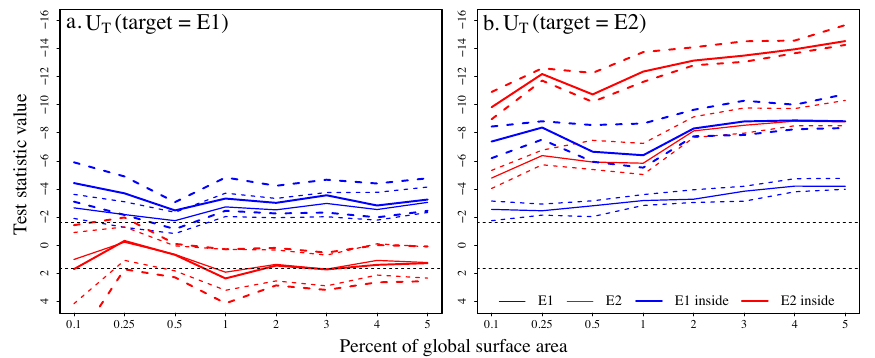
Fig. A1. As Fig. 7, with E1 (blue) and E2 (red) ensemble averages. The thick lines denote the use of inside averaging, whilst the thin lines denote outside averaging (as presented in Fig. 7). Note that the y-axis is extended here to accommodate the inside averaging